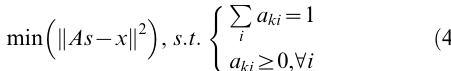
number of expression signature; (b) Root mean square deviation (RMSD) between the estimated fractions and the actual fractions